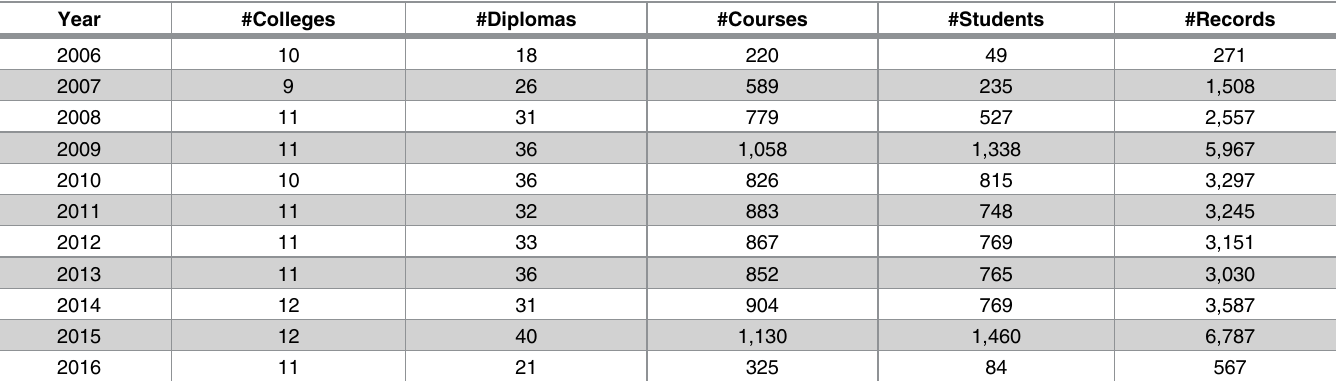
Table 5. Statistics for the cross-college course enrollment